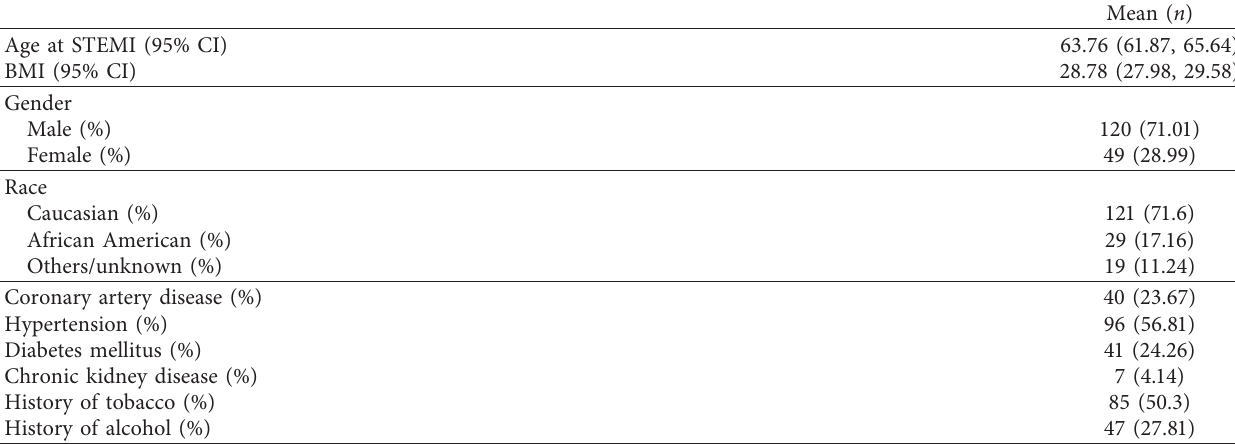
Table 1: Baseline demographic characteristics for entire population ( n � 169).